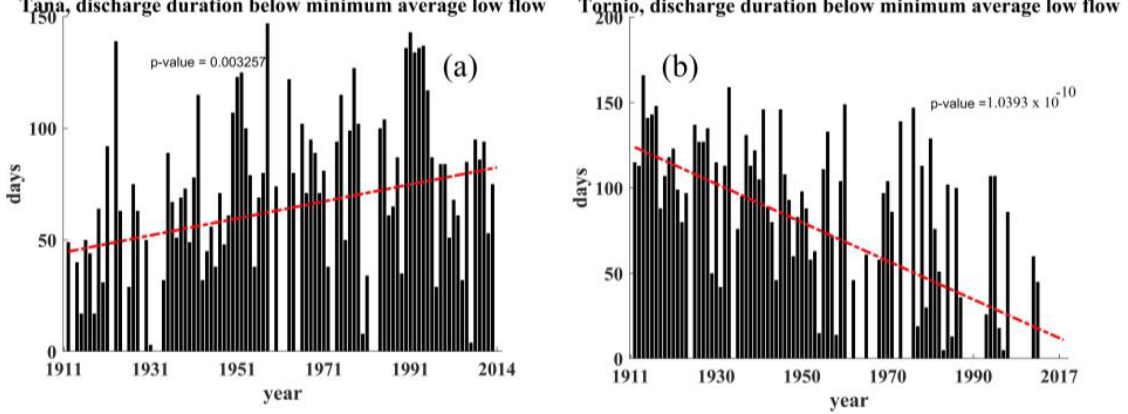
Figure 6. The trend of discharge duration below the minimum average low flow from Year365 for each river.